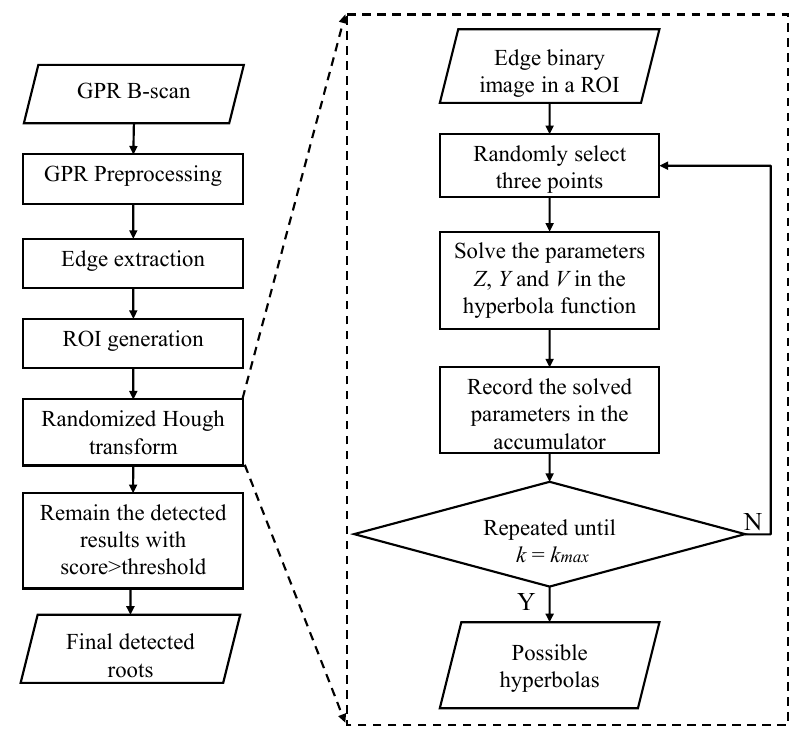
Figure 3. Flow chart of the automatic recognition algorithm based on randomized Hough transform (RHT).